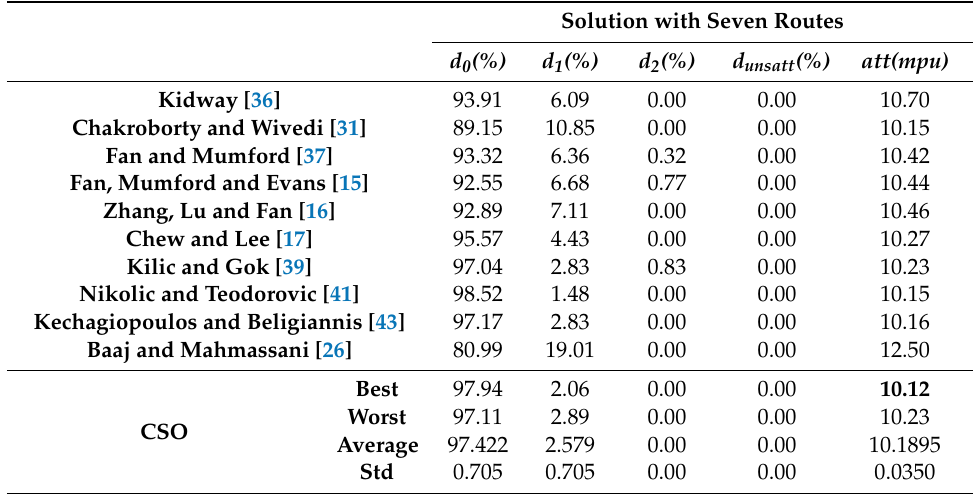
Table 7. Comparative results for the best seven-route solutions for Mandl’s network. Solution with Seven Routes